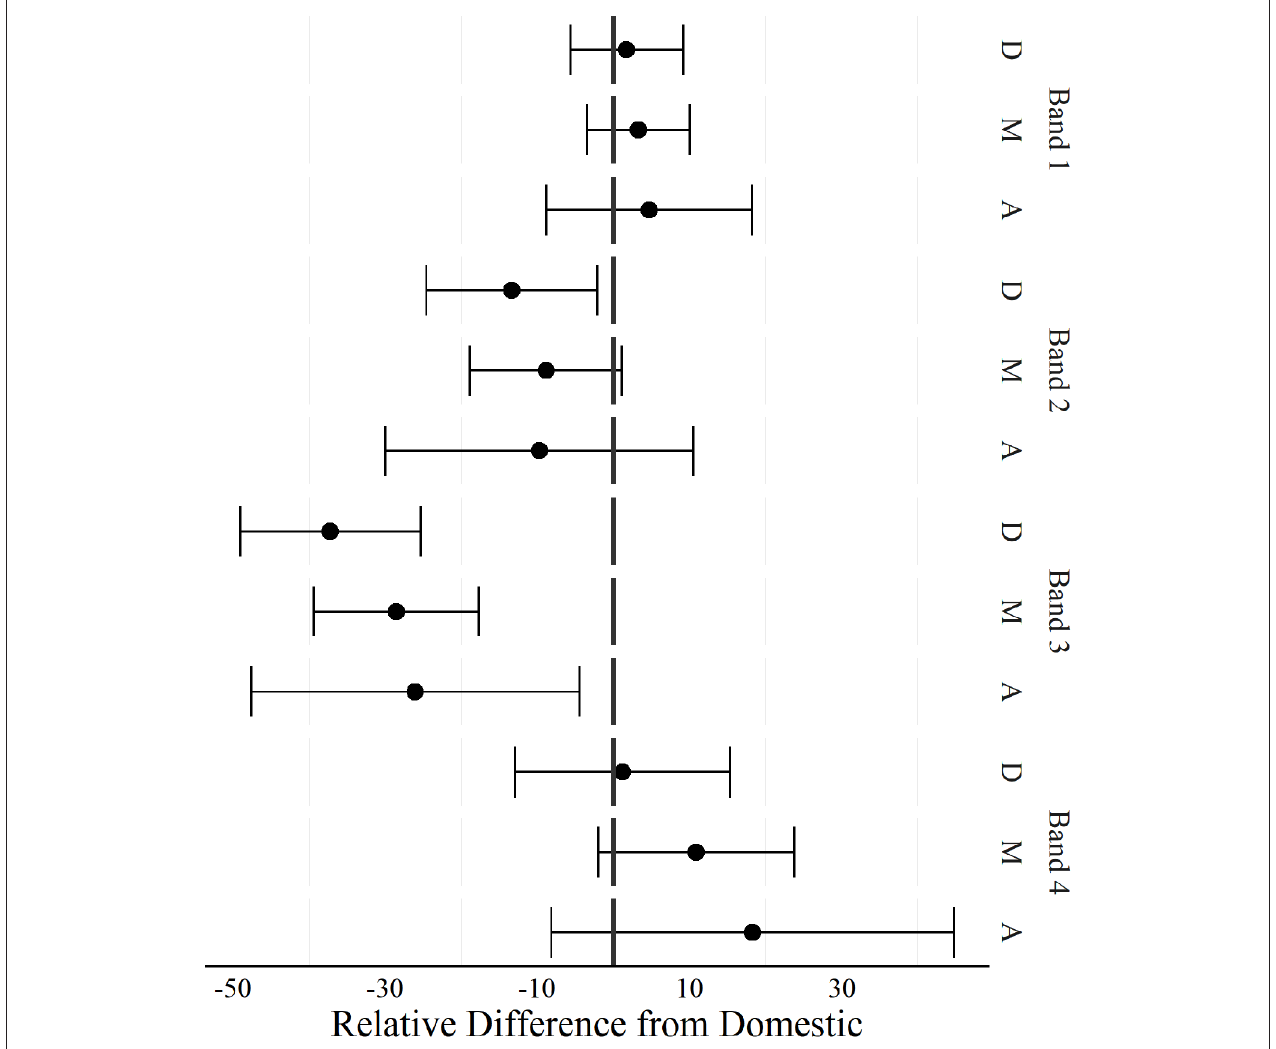
FIGURE 3 | Positional comparison of duration spent decelerating at different intensities between players competing in domestic and international women’s football matches. Band 1 ( − 1 to − 2 m · s − 2 ), band 2 ( − 2 to − 3 m · s − 2 ), band 3 ( − 3 to − 4 m · s − 2 ), band 4 ( < − 4 m · s − 2. ). D, Defenders; M, Midfielders; A, Attackers. A negative difference indicated, domestic was greater than international, a positive difference indicated international was greater than